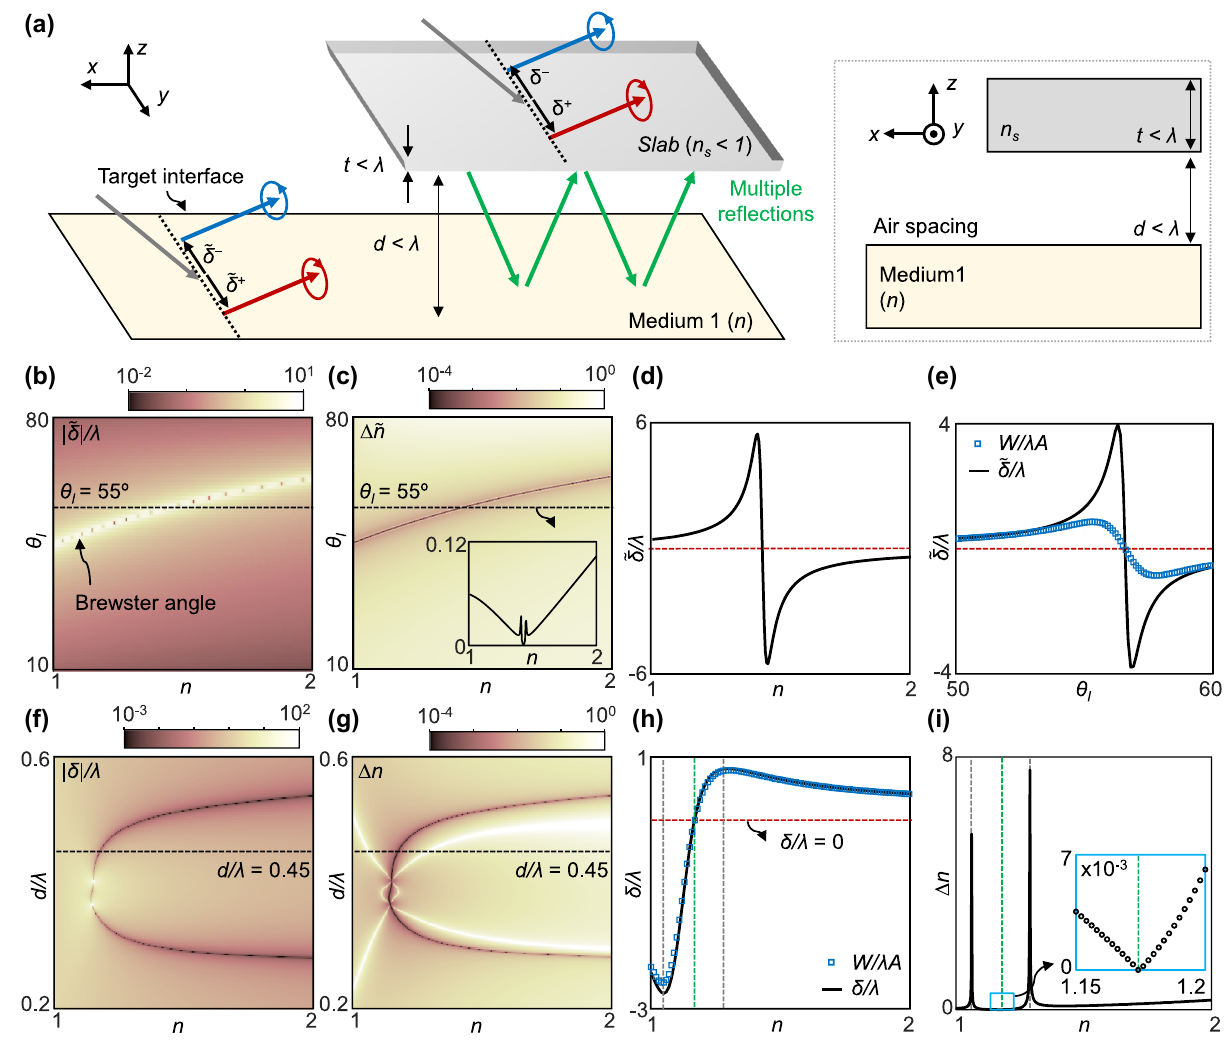
Figure 2: Precision enhancement using an index-below-unity slab. (a) Schematic of reflection in an unknown medium (medium 1) and is added. Inset: same schematic in the z – x plane. (b) Magnitude of the spin Hall shift at multiple reflections when a slab with an index of n s = 55 ◦ and (e) the air-medium 1 interface and (c) corresponding index resolution. (d, e) Cross section of the spin Hall shift when (d) 𝜃 I = 25 ◦ . (h) Spin Hall n = 1.515. (f) Magnitude of the spin Hall shift of the multiple-reflected beam and (g) corresponding index resolution at 𝜃 I shift and (i) index resolution when d ∕ 𝜆 = 0.45. All color maps are in the logarithmic scale. The blue markers in (e) and (h) represent the spin = 0, respectively. Hall shifts obtained by dividing the simulated W by A . The green and gray lines denote n where 𝛿 = 0 and d 𝛿 d n the reflected beam via a weak measurement. The spin Hall shifts at an interface characterized by the reflection coefficients of r s and r p are known as